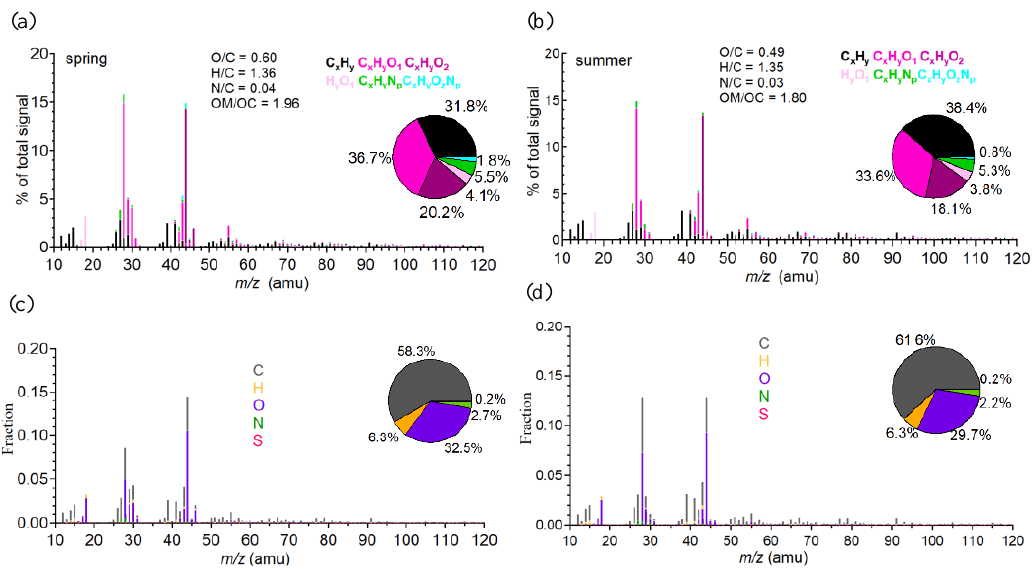
Figure 3. ( a ) High-resolution mass spectra (HRMS) profile of WSOA classified by six ion categories ( a ) in spring and ( b ) in summer and classified by five elements (C, H, O, N, and S) ( c ) in spring and ( d ) in summer. Elemental ratios and OM/OC ratio of each component are shown in the legends; mass fractions of C, H, O, N, S are shown in inserted pie chart.